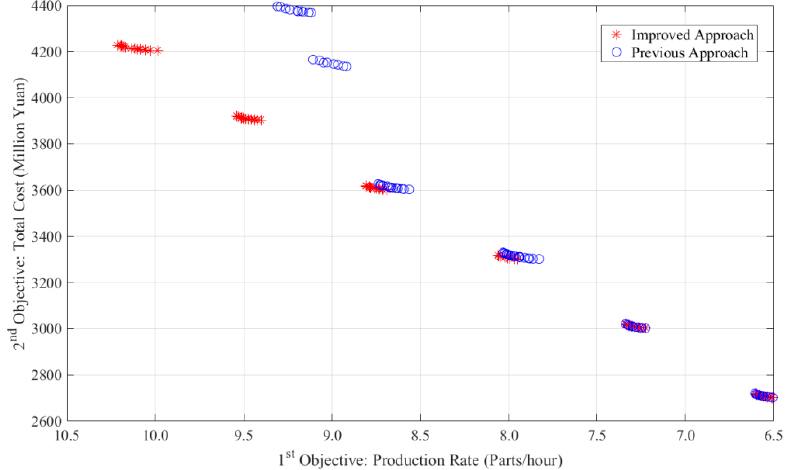
Figure A3. Comparison for Case C: results from the optimal sets of the additional runs.